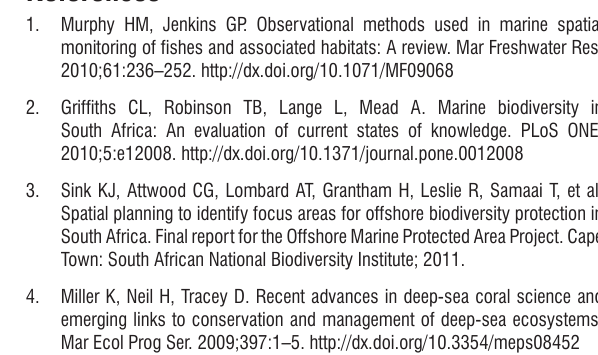
Fish species sampled by means of controlled angling (CA), fish trap (FT), remotely operated vehicle (ROV), remote underwater video systems (RUVs), baited RUVs (BRUVs) and underwater visual census (UVC) in the Tsitsikamma National Park Marine Protected Area during a simultaneous